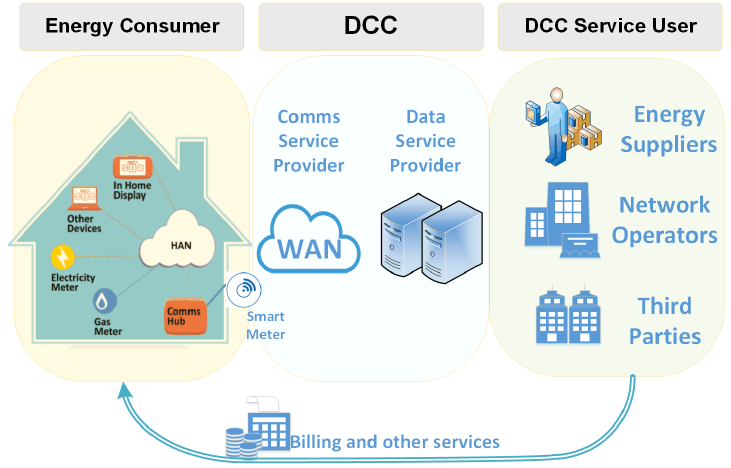
Figure 1. The structure of the current smart metering system.